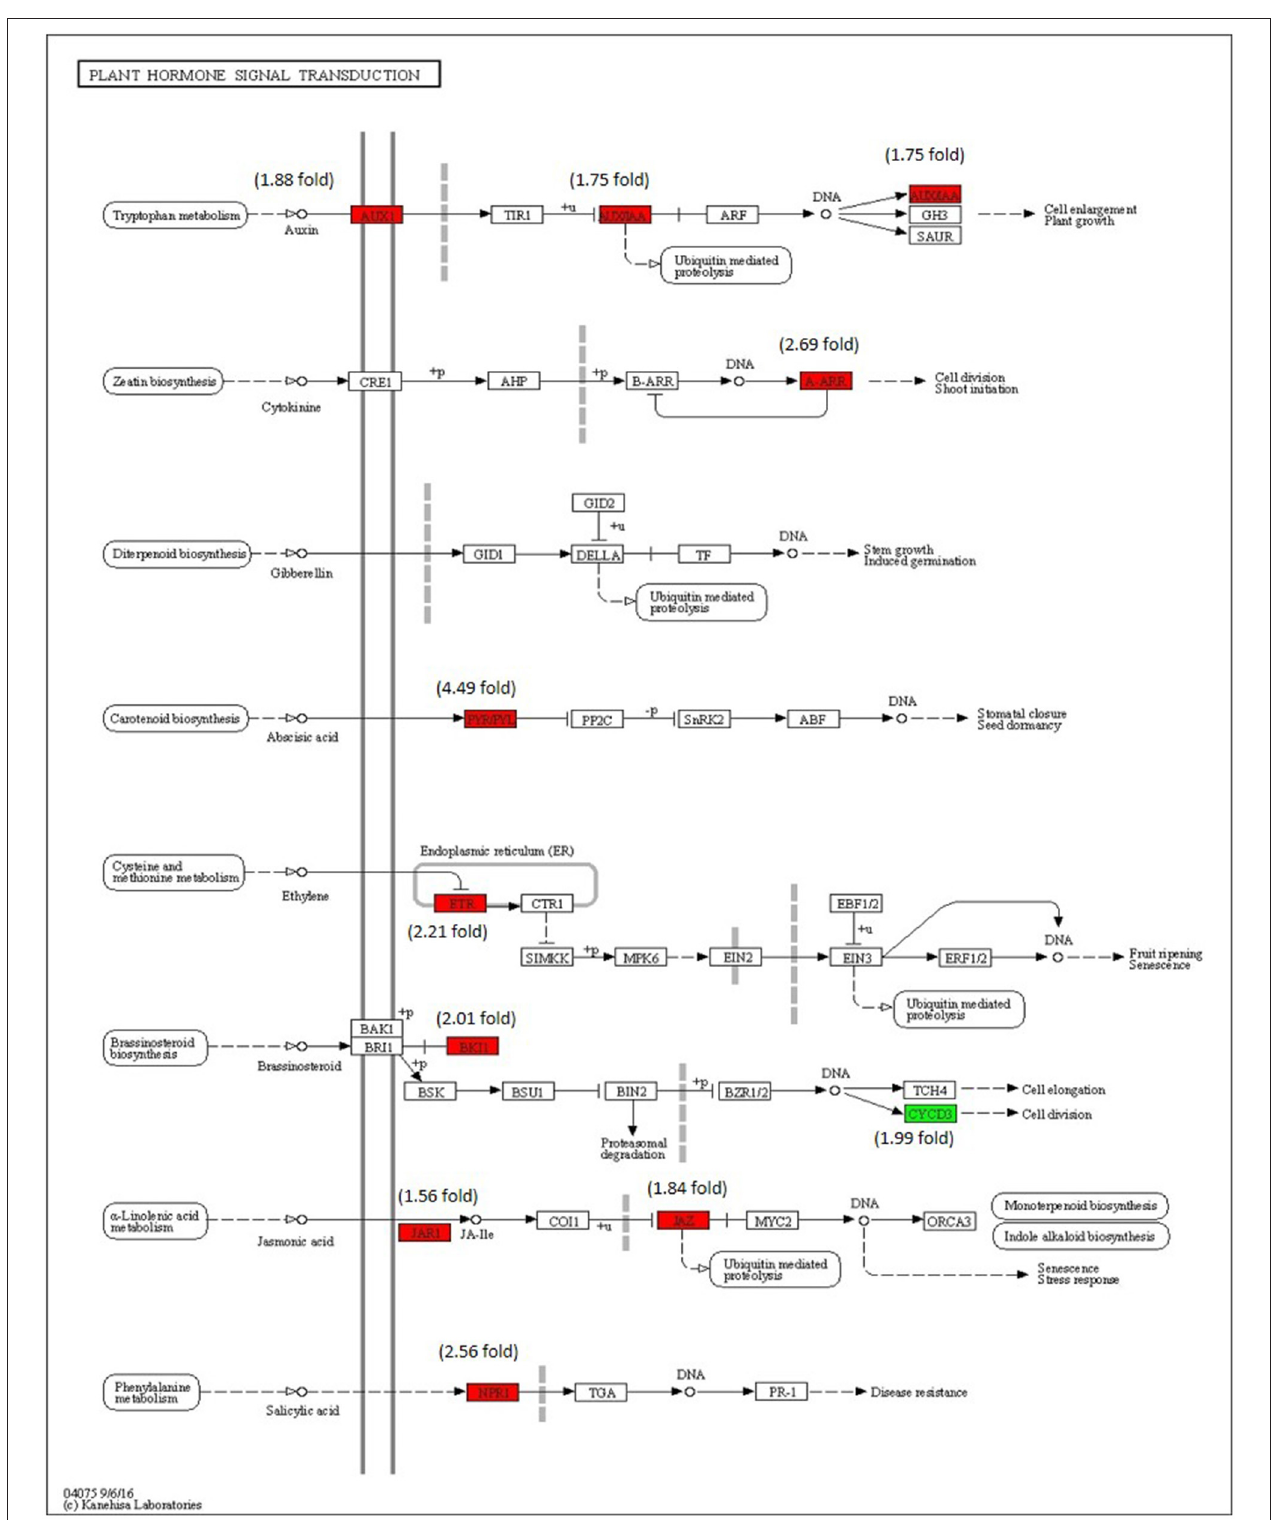
FIGURE 8 | Modulation of gene expression in plant hormone signaling pathways (salicylic acid (SA), jasmonic acid (JA), ethylene (ET) and brassinosteroid pathways) in tomato plant by Cg-2 treatment. (Red color represents upregulated genes and green color represents downregulated genes).